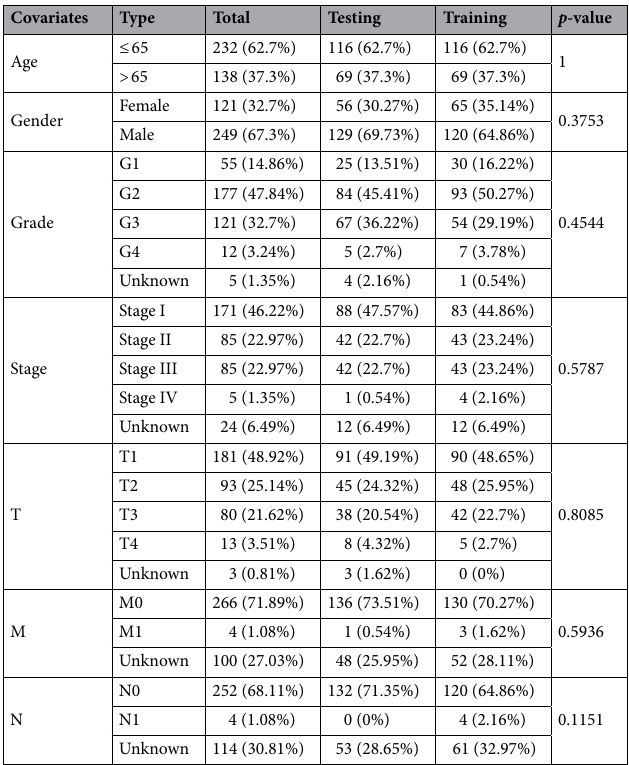
Table 2. The detailed clinicopathologic factors information between the training and testing